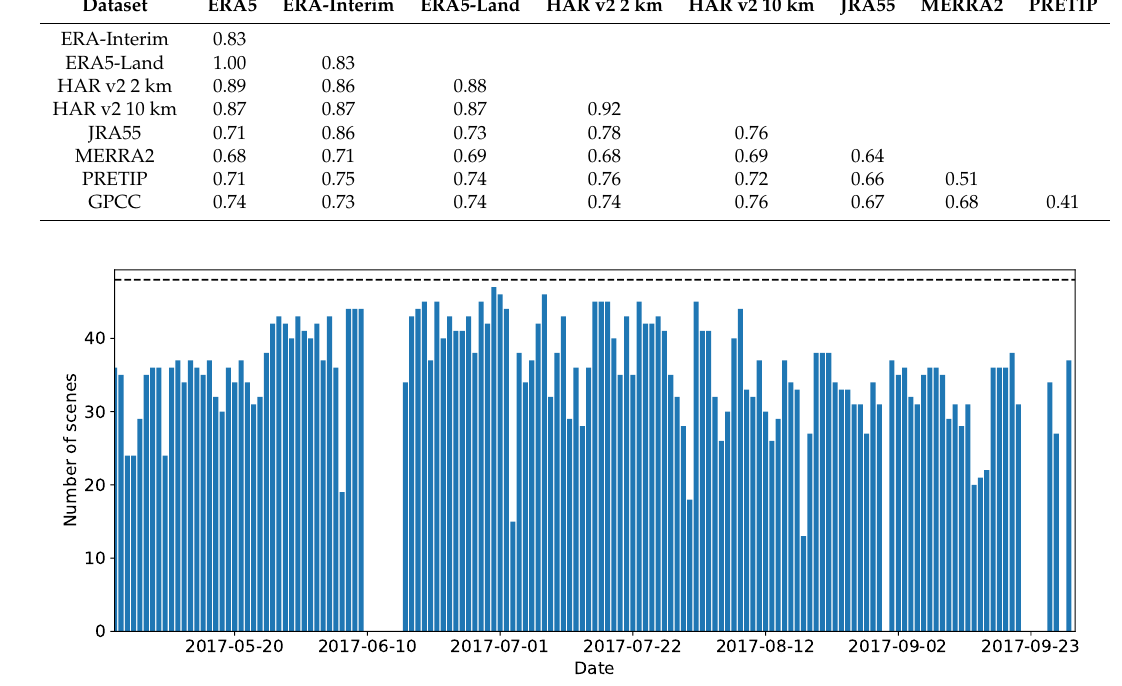
Figure A1. Amount of available PRETIP scenes per day. The maximum value is 48 (2 scenes per hour) and marked with the black dotted line. On average, 32.6 scenes per day are